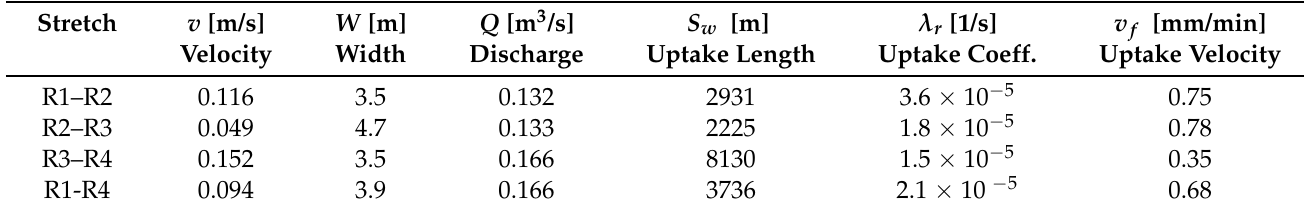
Table 3. Metrics of the movable phosphorus uptake between sampling